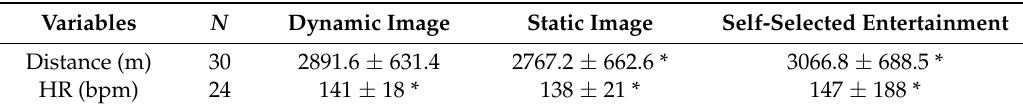
*: indicated that p <